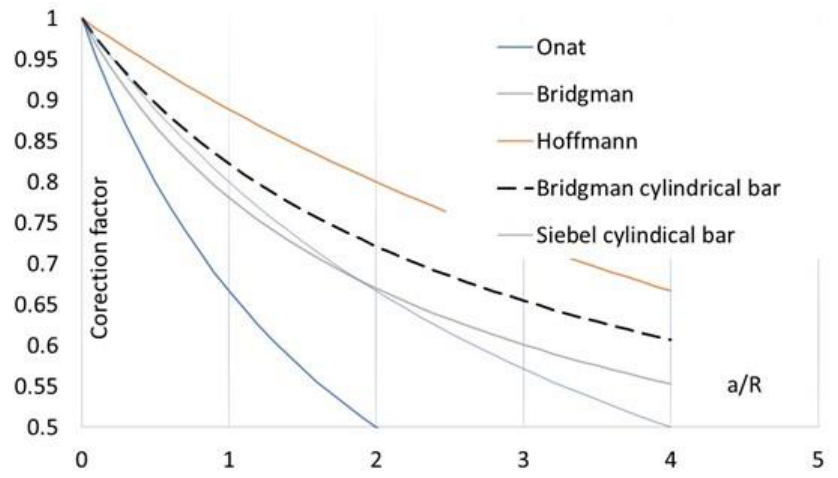
Figure 5. Comparison of stress correction parameters.